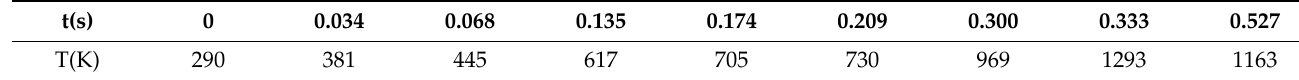
Table 1. Infrared temperature of the MgB 2 sample at different time points.